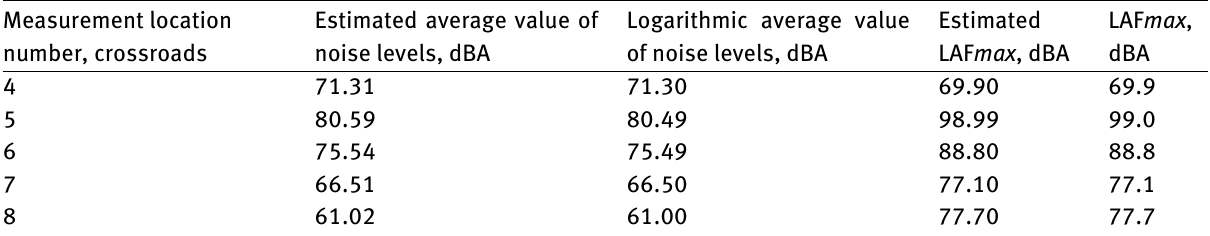
Table 5: Estimated noise levels in crossroads. Measurement location number is the same as in Table 2. Measurement